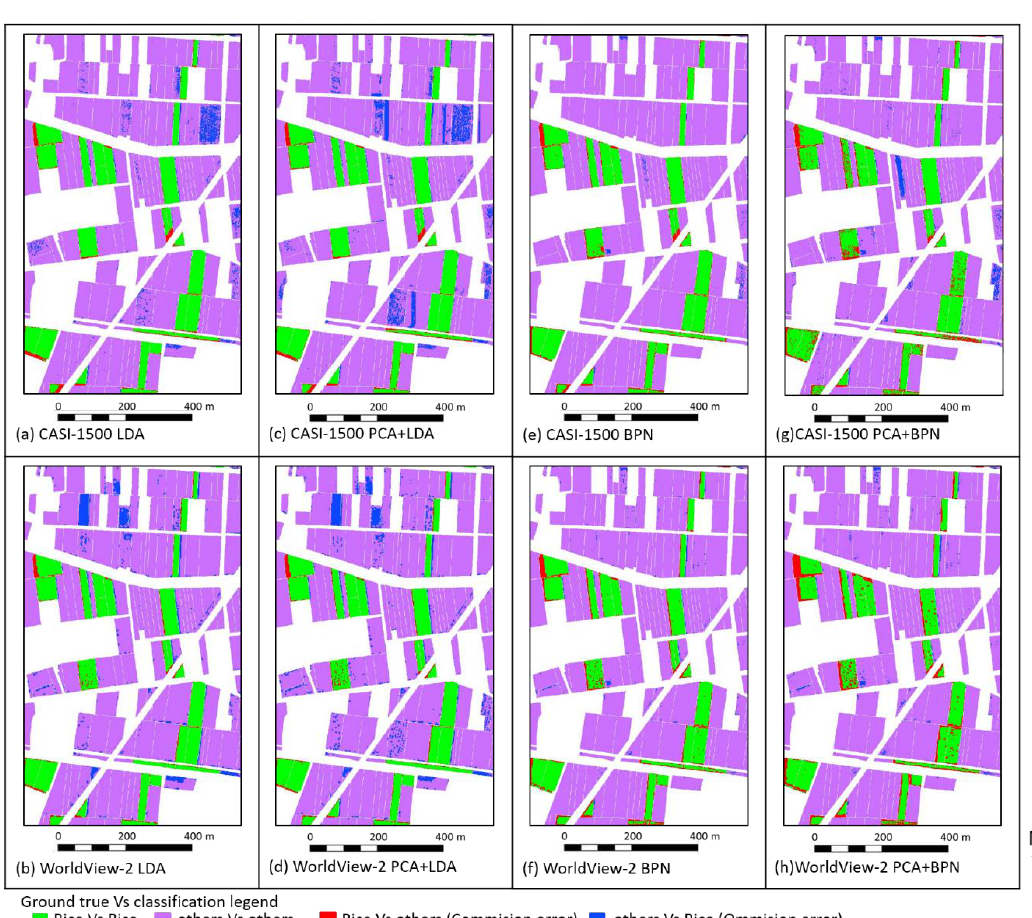
Figure 6. Thematic map of the full-size image supervised classification of LDA and BPN on CASI-1500 (hyperspectral) and WorldView-2 (multispectral) with/without feature selection. Note: the red parts are rice, classified as other categories (commission error). The blue parts are others, classified as rice (omission error). ( a ) CASI-1500 LDA; ( b ) WorldView-2 LDA; ( c ) CASI-1500 PCA+LDA; ( d ) WorldView-2 PCA+LDA; ( e ) CASI-1500 BPN; ( f ) WorldView-2 BPN; ( g ) CASI-1500 PCA+BPN; and ( h ) WorldView-2 PCA+BPN.